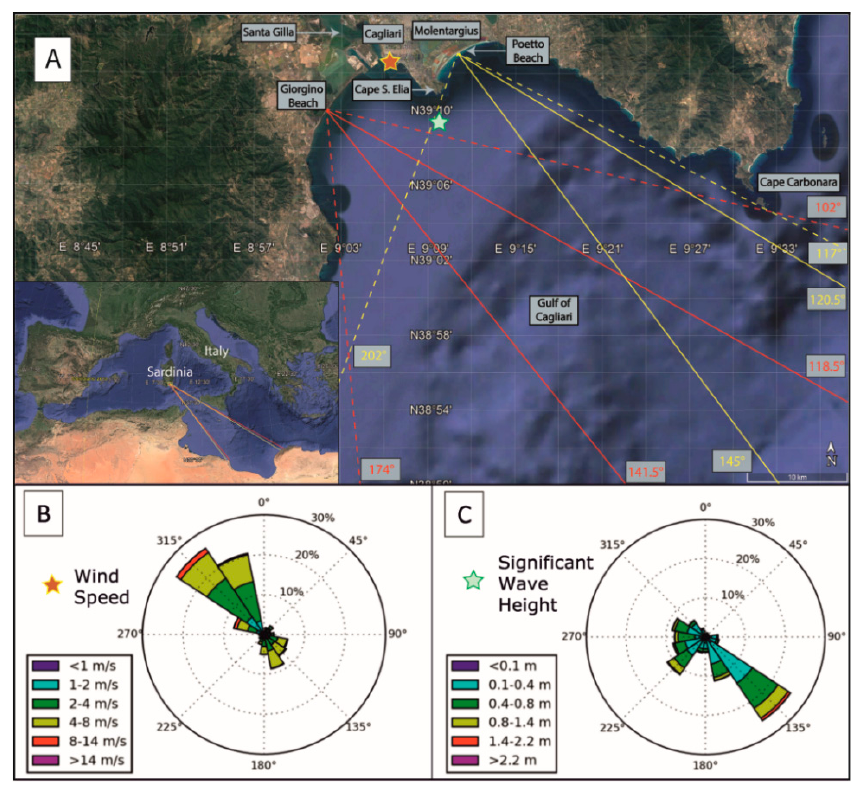
Figure 2. Geographical settings of the study area (Gulf of Cagliari, western Mediterranean Sea) with: ( A ) wave exposure angles (referred to the N = 0°) and fetch for Poetto (yellow lines) and Giorgino (red lines) beaches. ( B ) Wind speed and direction from the Cagliari station of the national tidal monitoring network (location: orange star; period 2010–2015). ( C ) Significant wave height and direction at the National Oceanic and Atmospheric Administration (NOAA) hindcast dataset point (location: green star; period 1979–2009). Image obtained from Porta et al. [38].